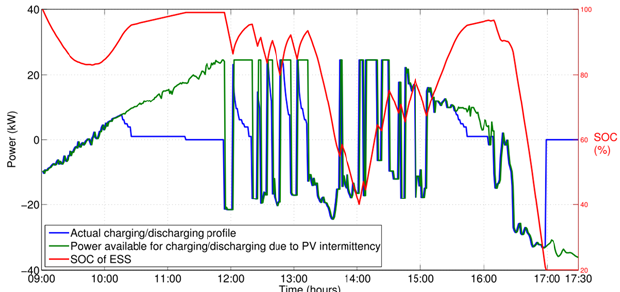
Figure 1. Comparison of charging/discharging power available due to the intermittency of solar PV and charging/discharging profile of the SBS.